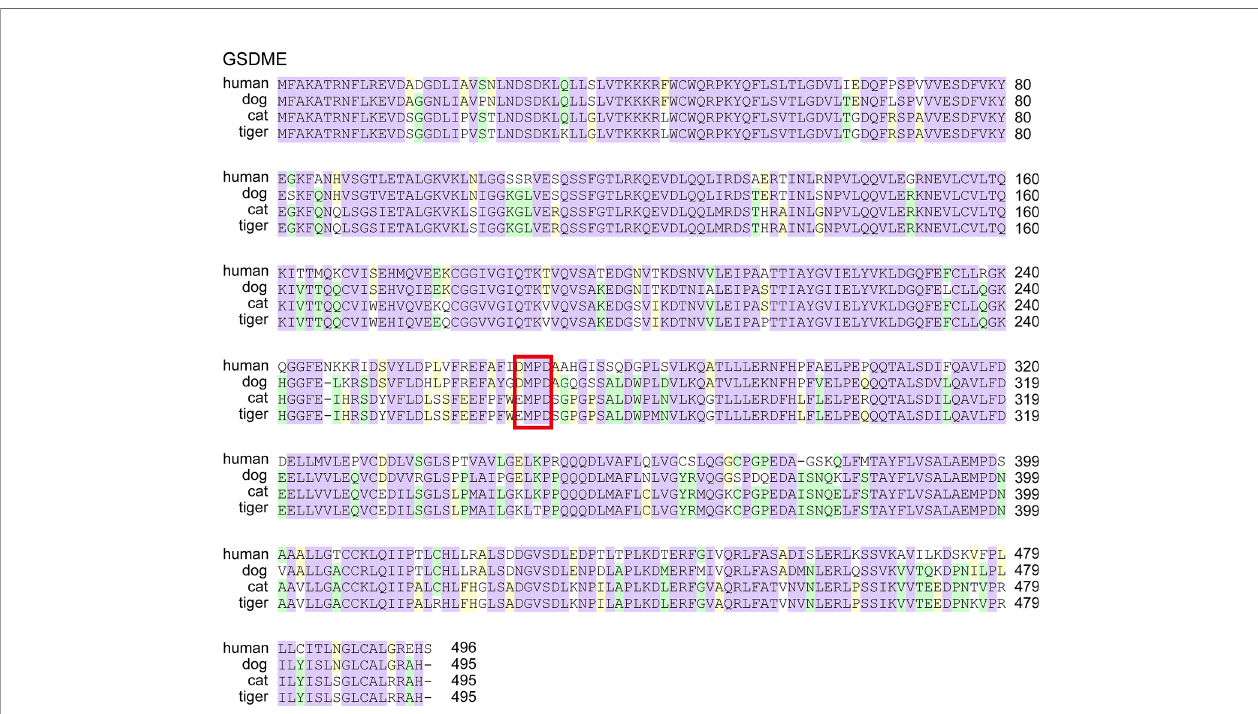
FIGURE 6 | GSDME from cats and tigers lose the cleavage sites of caspase-3 and granzyme B Protein sequences of GSDME from humans, dogs, and tigers were aligned. The key cleavage sits are boxed in red.